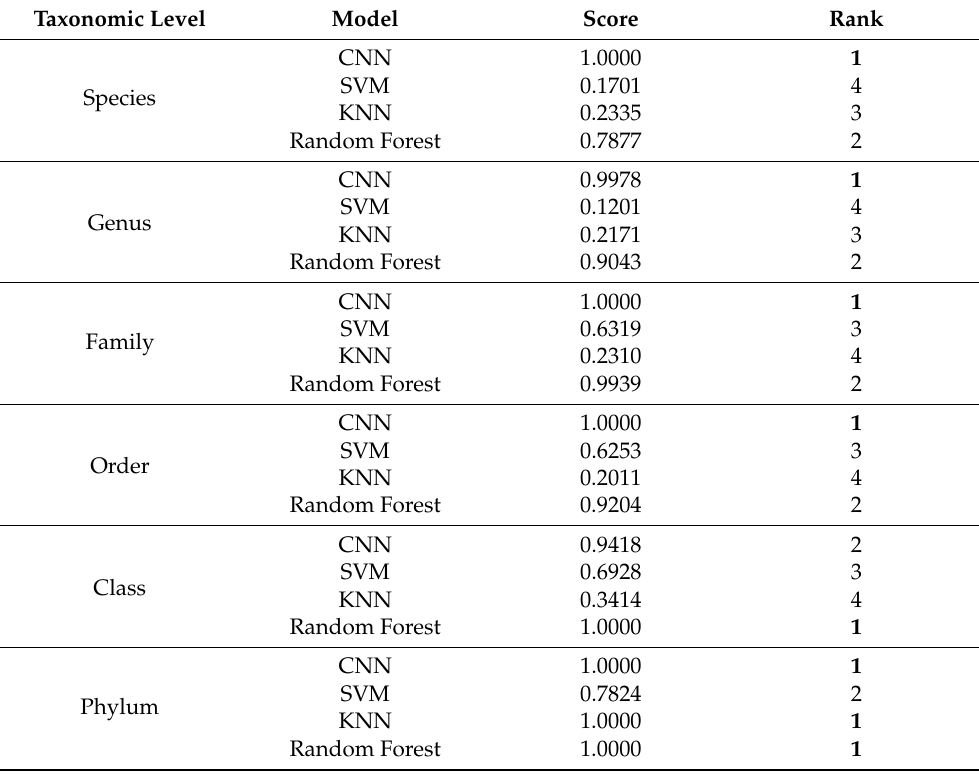
Table 8. Ranking of CNN, SVM, KNN and Random Forest classifiers based on Topsis analysis at various taxonomic levels. Performances of all models have been evaluated based on five evaluation metrics (accuracy, precision, recall, F 1 score and MCC score ) with equal weightage using 6-mer frequency features. Highest ranks are highlighted in bold.